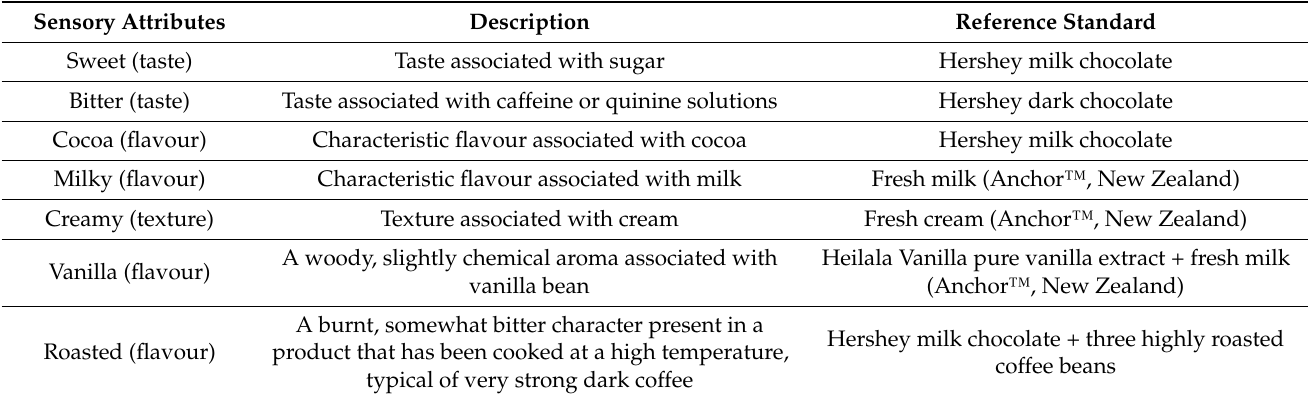
Table 1. Sensory attributes and descriptions of chocolate ice